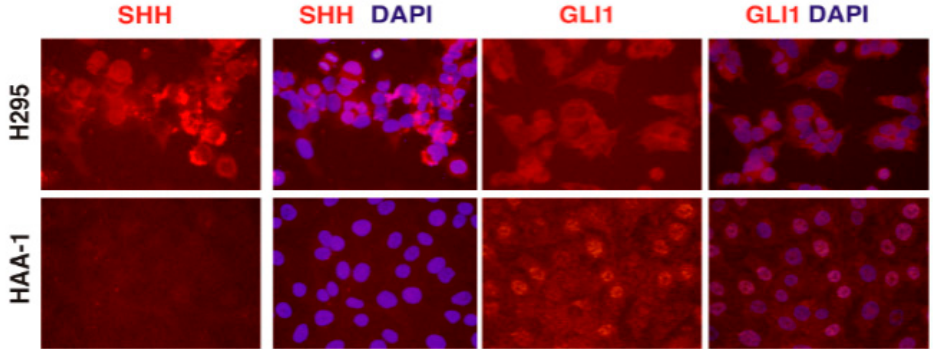
Figure 2. HAA1 cells exhibit some characteristics of the progenitor cells of the adrenal. HAA1 cells ( bottom panels ), but not NCI-H295 cells ( top panels ), express GLI1 protein that is also expressed in the sub-population of the adrenal stem cells, but not SHH. H295 cells express SHH protein. Scale bar, 50 μ .